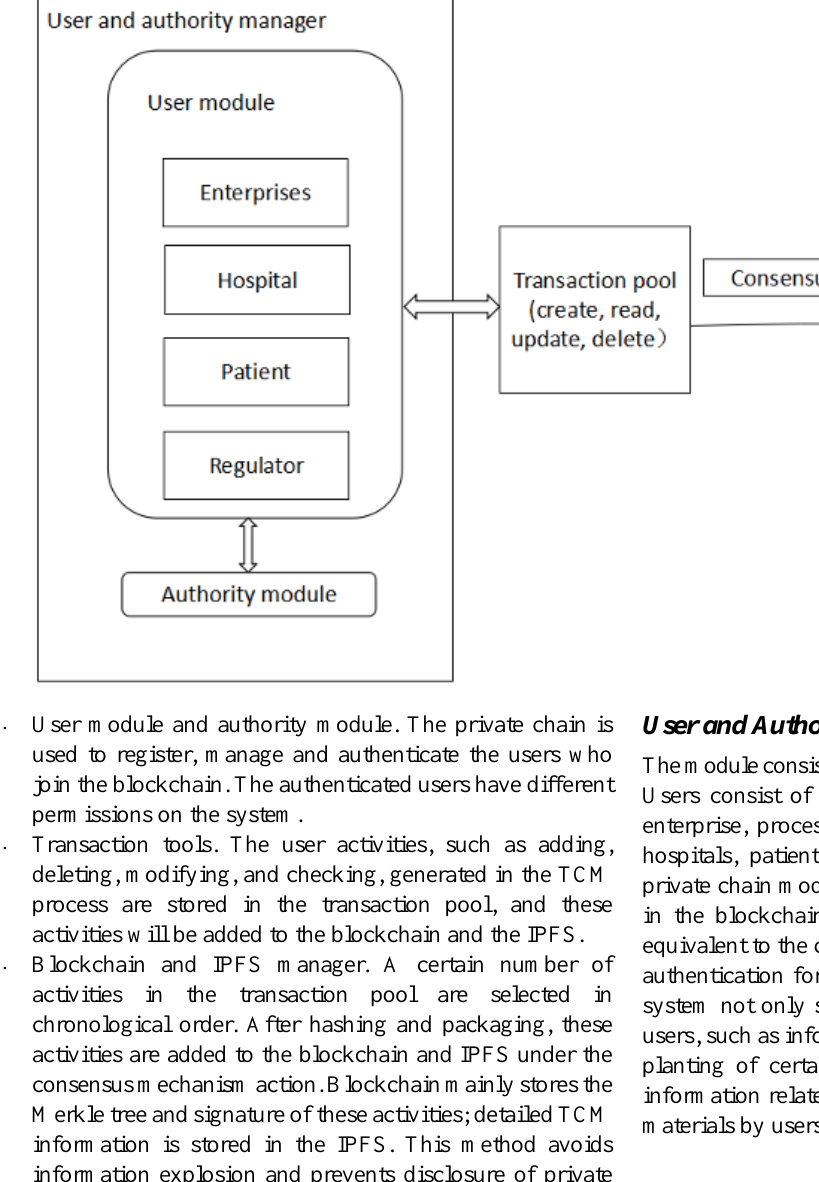
Figure 1. The architecture of the Chinese medicine traceability system based on